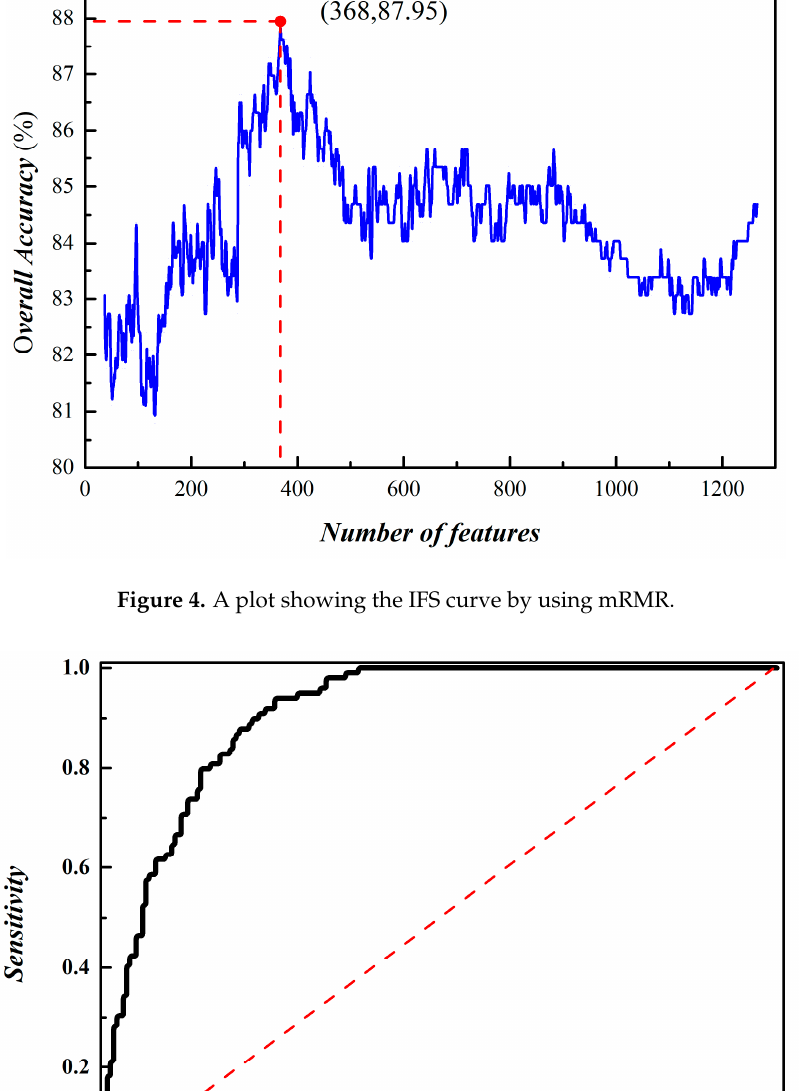
Figure 3. A heat map for 1266 features based on different Z-scores.